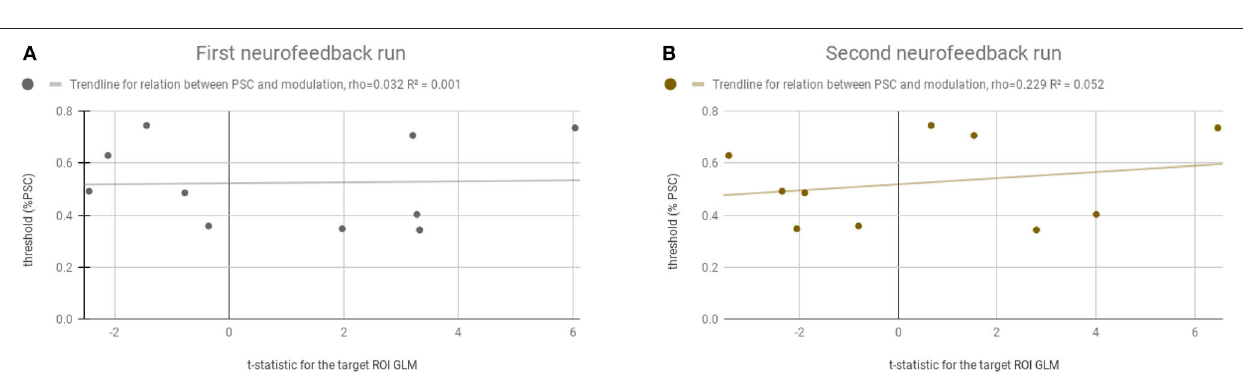
FIGURE 6 | Relation between the computed adaptive threshold and the success in the neurofeedback runs. Y-axis represents the threshold (% PSC) selected for each participant and the x-axis represents the t-statistic for the ROI-GLM contrast (within the neurofeedback target) (4OMI + 2OMI < SI). (A) Represents the first neurofeedback run. (B) Represents the second neurofeedback run.